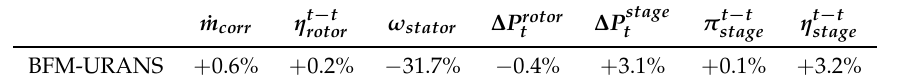
Table 2. Relative discrepancy between URANS and body force modeling (BFM) global performance.